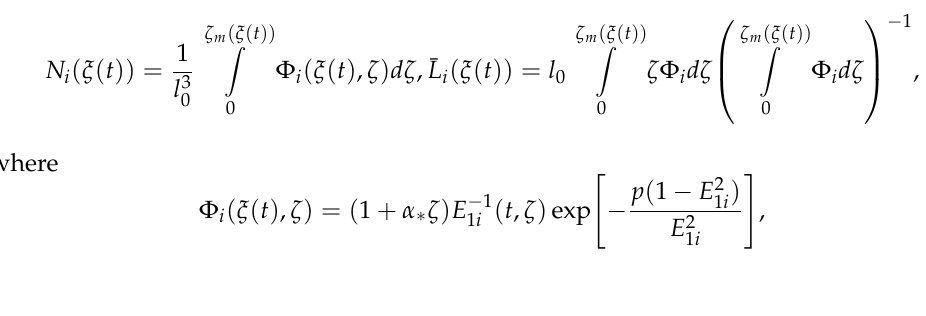
( a ) and average crystal size u i = N 3 ( ξ ∗ ) for supercooled melts with WVFZ kinetics, p = 7.4, τ 0